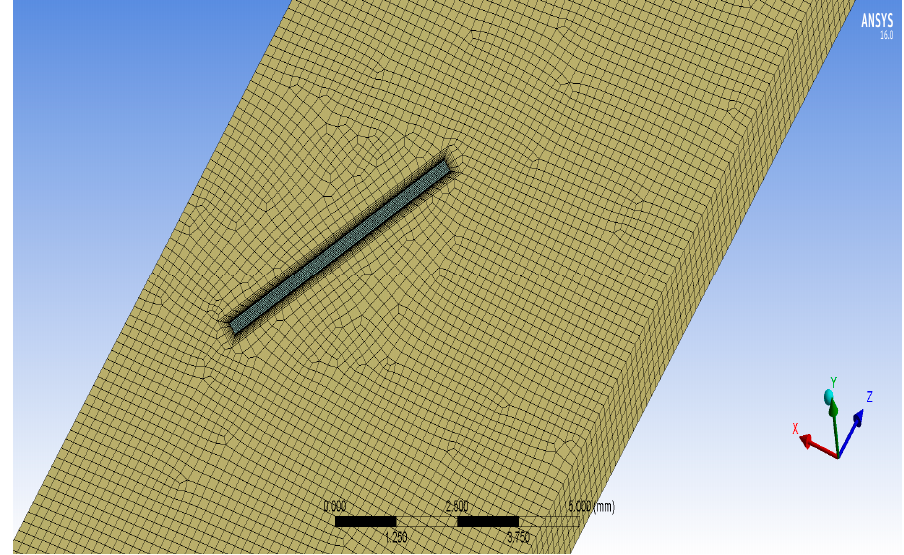
Figure 2. The grid generation of the computational model. Processes 2020 , 8 , x FOR PEER REVIEW